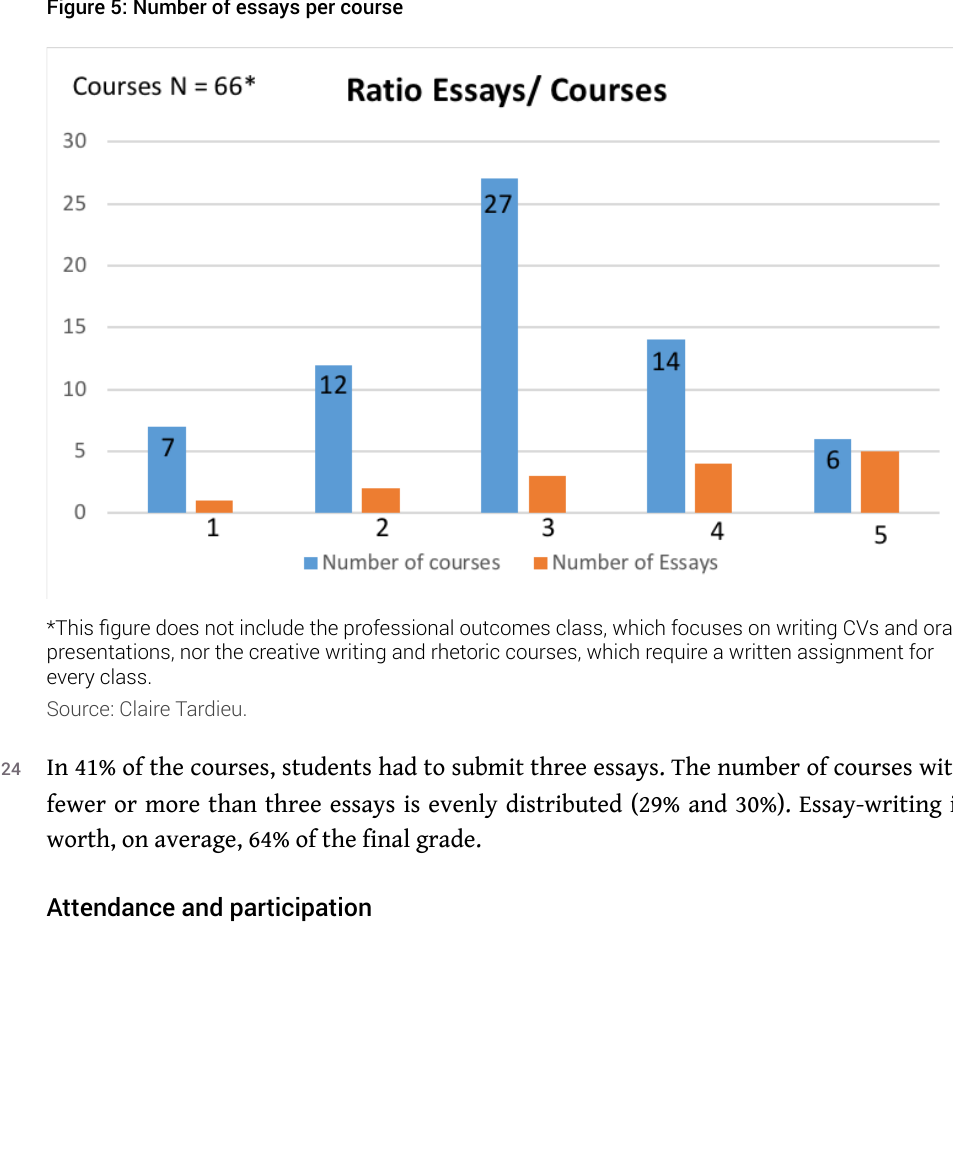
Figure 5: Number of essays per